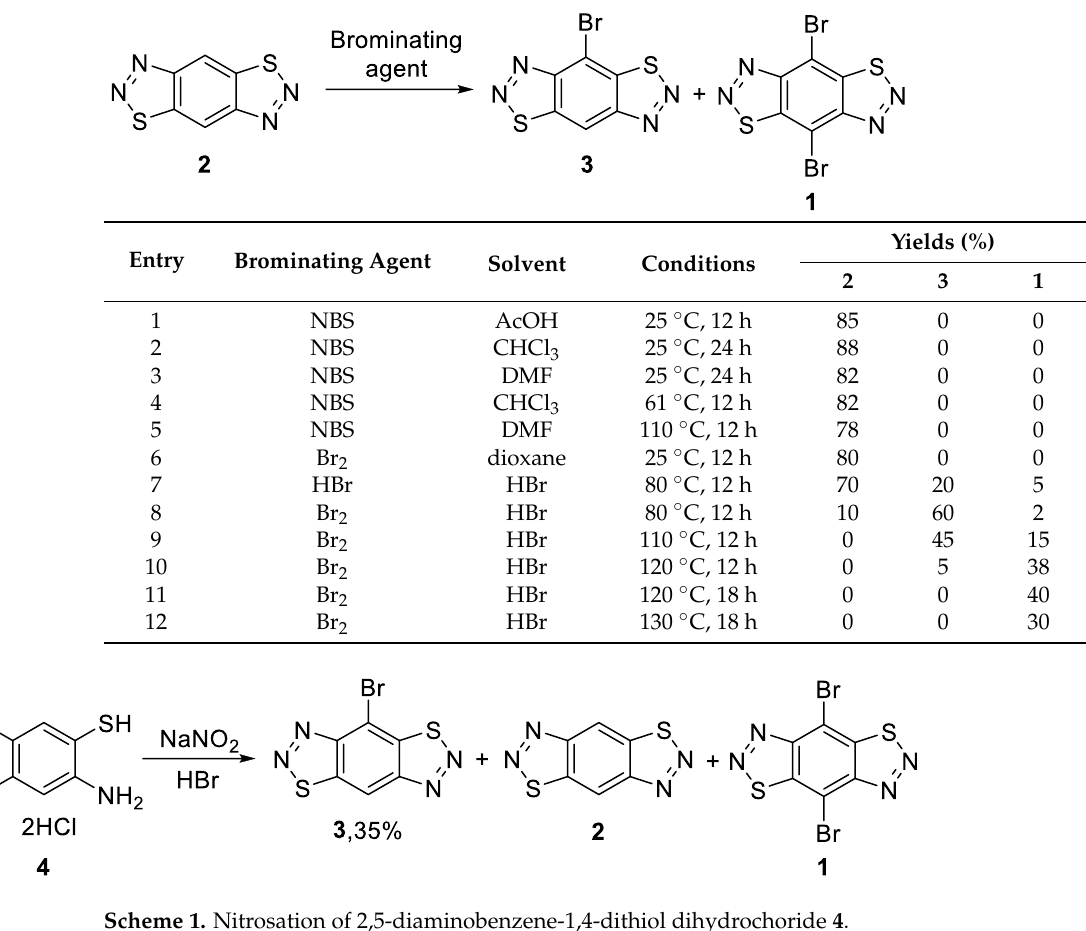
Table 1. Bromination of benzo[1,2- d :4,5- d ’]bis([1,2,3]thiadiazole) 2